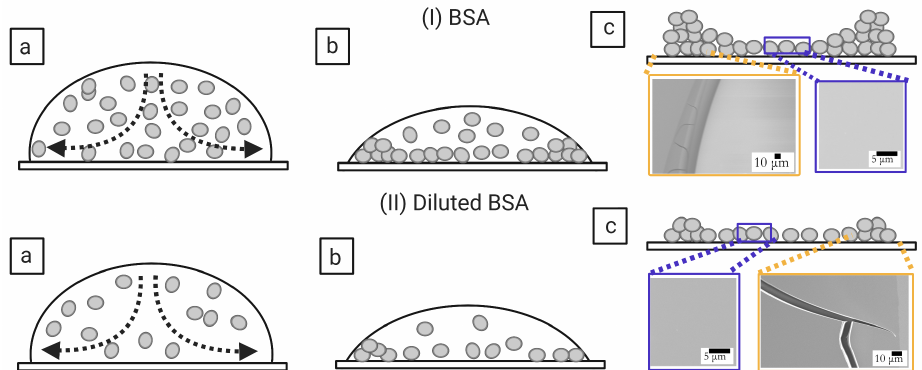
Figure 15. The BSA droplet’s physical mechanism during the drying process at φ p = 20 wt% in (( I )a–c) and at φ p = 1 wt% in (( II )a–c). The capillary flow is indicated with the dotted arrows in (( I , II )a). The blue and the orange rectangles in (( I , II )c) display the microstructures in the central and the rim regions (both 20 and 1